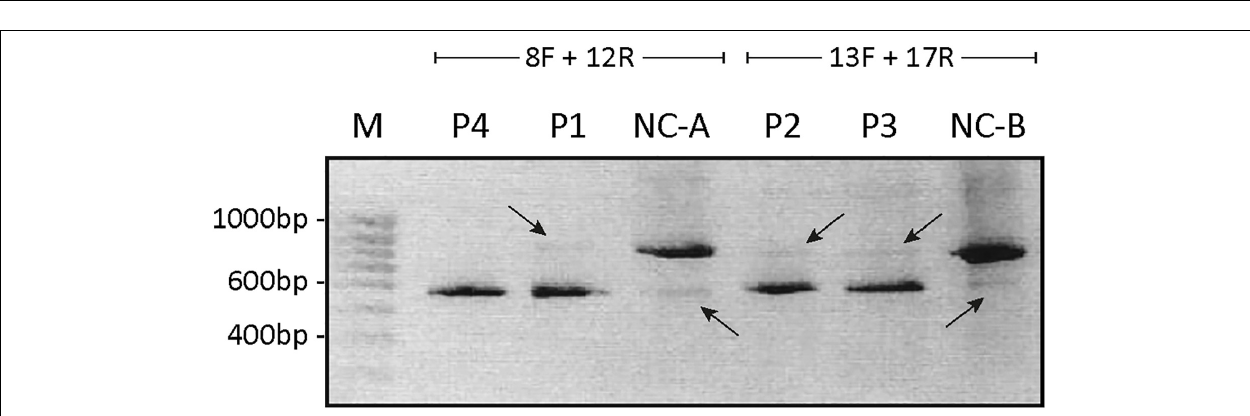
FIGURE 1 | SDS-PAGE and Western blotting (WB) analysis of cell lysates from P1–P5 fibroblasts. Antibodies against ATP7A were used as indicated. Positive normal control fibroblasts (NC) and negative control fibroblasts ( (cid:49) C), from a Menkes disease (MD) patient hemizygous for deletion of the entire ATP7A gene were included. An intense band representing wild-type ATP7A was observed in NC. In all the patients, P1–P5 only bands present also in (cid:49) C were observed. M indicates the protein ladder. WB of the GAPDH probe from similar samples was used as loading control.